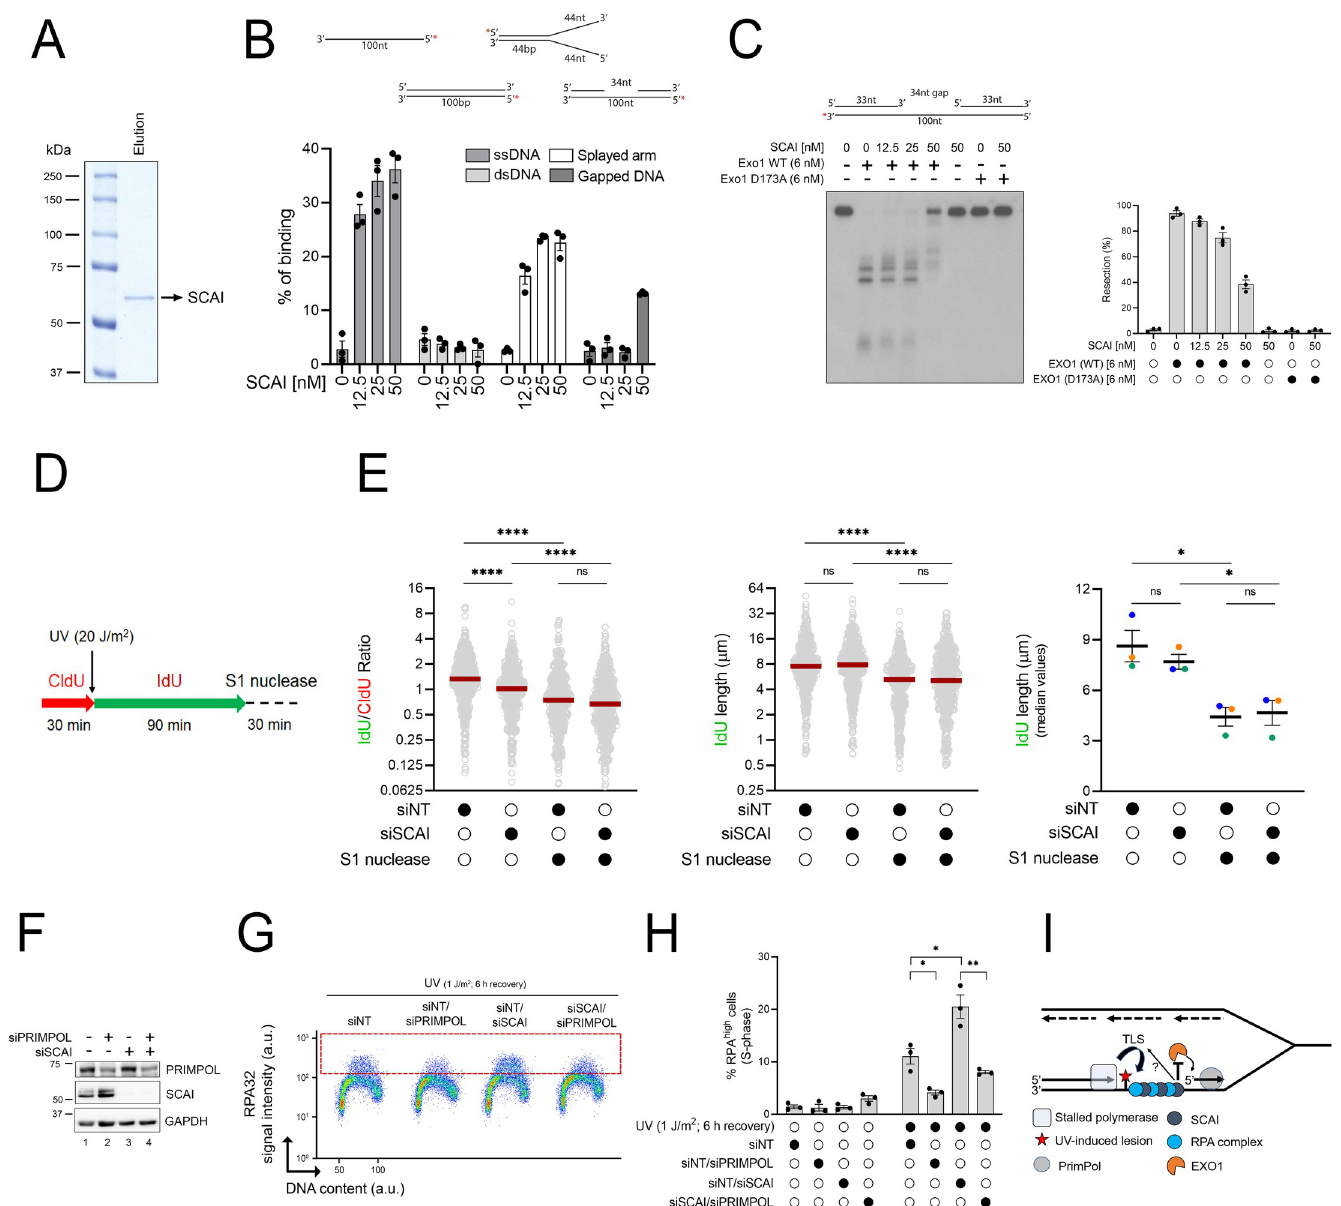
Fig 7. SCAI inhibits EXO1-mediated DNA resection at ssDNA gaps. (A) Recombinant SCAI protein was purified from insect cells, separated by SDS-PAGE and visualized by Coomassie blue staining. ( B) SCAI preferentially binds ssDNA over dsDNA. 5 0 -[ 32 P]-labeled ssDNA, dsDNA, splayed arm, or gapped DNA were incubated with purified recombinant SCAI at increasing concentrations and the reaction products separated by acrylamide gel electrophoresis and visualized by autoradiography (see S6A Fig). Quantification of the percentage of SCAI-mediated DNA binding on ssDNA, dsDNA, and splayed arm substrates from 3 independent experiments. ( C) Left: in vitro DNA resection assays using a 3 0 -[ 32 P]-labeled gapped DNA substrate in the absence of any proteins, or with WT or a catalytically inactive version of EXO1 (D173A) supplemented with purified recombinant SCAI. Right: quantification of the percentage of DNA resection from 3 independent experiments. ( D, E) Depletion of SCAI does not increase ssDNA gap generation post-UV. ( D) Schematic of the DNA fiber assay used to assess RF progression post-UV. Cells were incubated with CldU (red) for 30 min, irradiated with UV (20 J/m 2 ), and then incubated with IdU (green) for 90 min. Cells were then treated or not with S1 nuclease. ( E) Left panel: dot plot and median (red line) of IdU/CldU ratio from cells transfected with siRNAs as indicated. Middle panel: dot plot and median of IdU tract lengths (DNA fiber dot plot are combined from n = 3 with similar result). Right panel: histogram of median values of IdU track length derived from independent experiments. Means and SEM are plotted as lines and whiskers. ( F-H) Depletion of PrimPol rescues ssDNA-RPA accumulation in cells lacking SCAI. ( F) Validation of siRNA- mediated KD of PrimPol and SCAI by immunoblot. ( G) Representative immunofluorescence flow cytometry plots from cells transfected with the indicated siRNA treated with 1 J/m 2 UV or mock-treated and allowed to recover for 6 h. The dashed red box delineates DNA-bound RPA high cells. ( H) Quantification from (G). Histogram values represent the mean ± SEM from 3 independent experiments. (I) Proposed model. After UV exposure, PrimPol-dependent repriming generates ssDNA gaps behind RF. These gaps recruit RPA and SCAI, and SCAI acts to restrain the resection activity of EXO1. Possible modulation of Pol z /REV3L-dependent